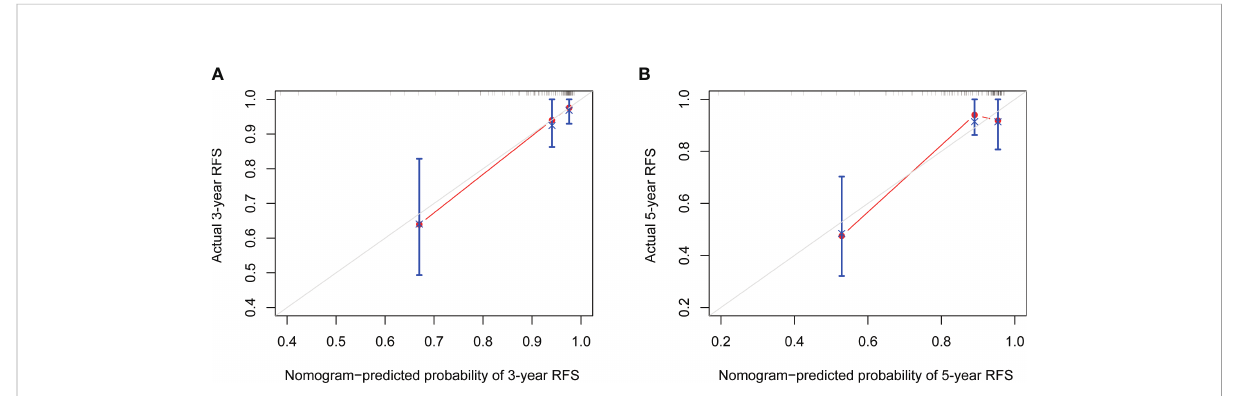
FIGURE 5 The calibration curve of nomogram for predicting 3-year (A) and 5-year (B) RFS. RFS, recurrence-free